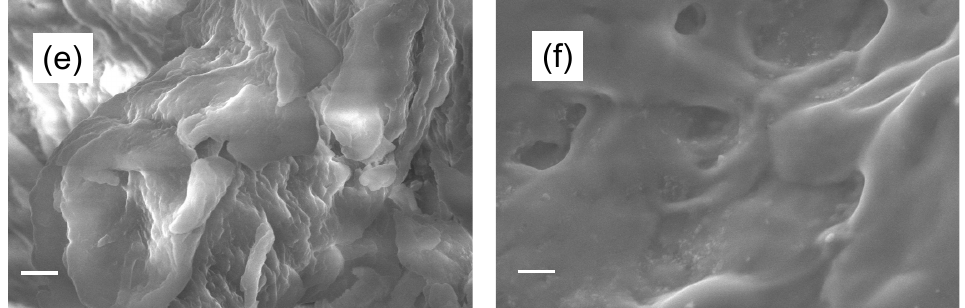
Figure 3. SEM images of ( a ) BC, ( b ) CMC ‐ 0 h, ( c ) CMC ‐ 1 h, ( d ) CMC ‐ 2 h, ( e ) CMC ‐ 4 h, and ( f ) CMC ‐ 12 h.